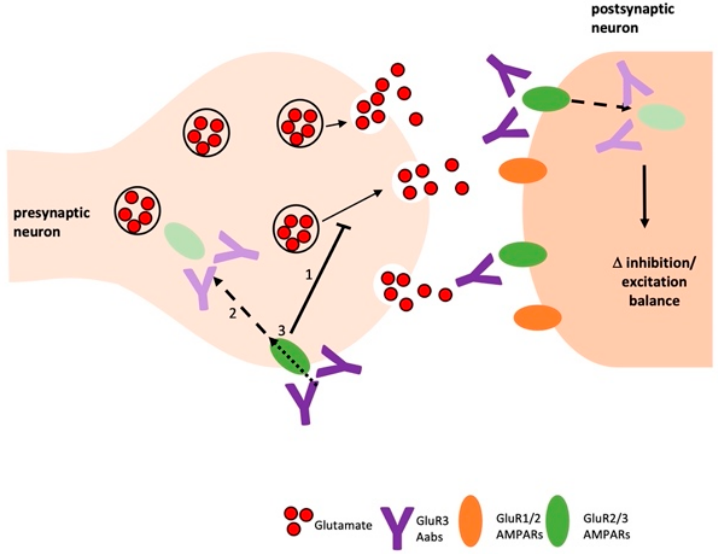
Figure 6. Schematic of potential mechanisms of anti-AMPAR Aabs. Anti-AMPAR Aabs may exert their inhibitory effect on glutamate release via presynaptic AMPARs. Additionally, anti-AMPAR Aabs may cause antibody-induced internalisation of AMPARs pre- and/or post-synaptically, resulting in an imbalance of the excitatory/inhibitory network.